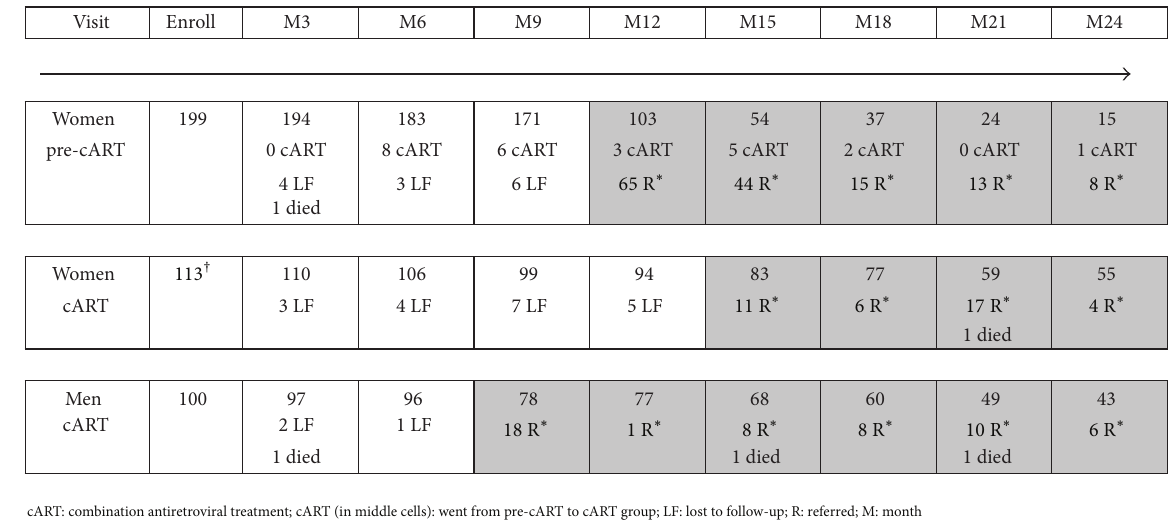
Figure 1: Participants